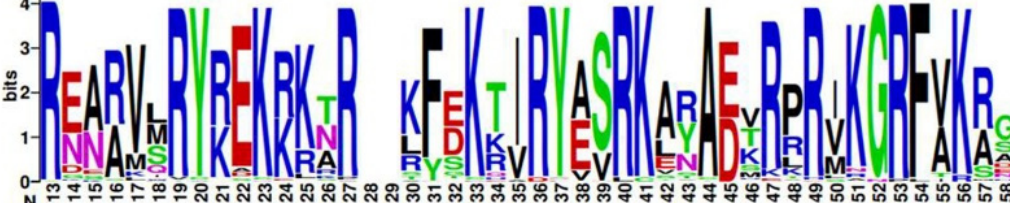
Figure 3. Web logos of BrBBX proteins. ( a – c ) Alignments of the B-box1, B-box2, and CCT domains, respectively. The x -axis indicates the conserved domain sequences. The height of each letter indicates how conserved the residue is across all proteins. The y -axis presents the relative entropy, which reflects the conservation rate of each amino acid.